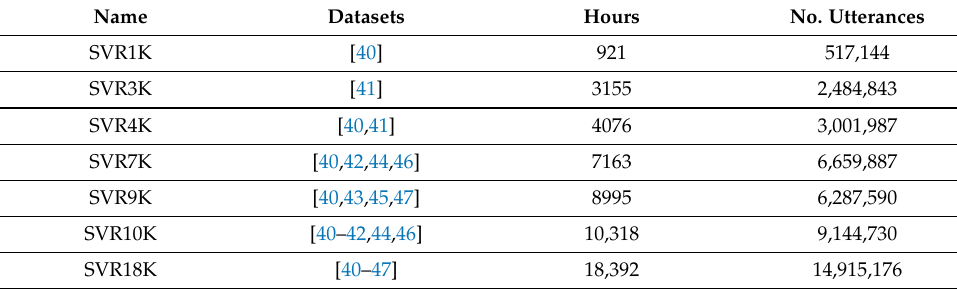
Table 3. Different amount of pretraining data for SVR learning.